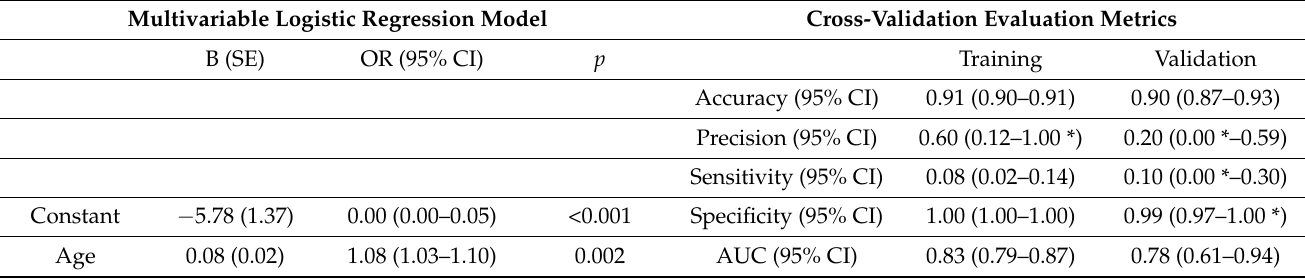
Table 7. Parameters and validation metrics of the predictive model of